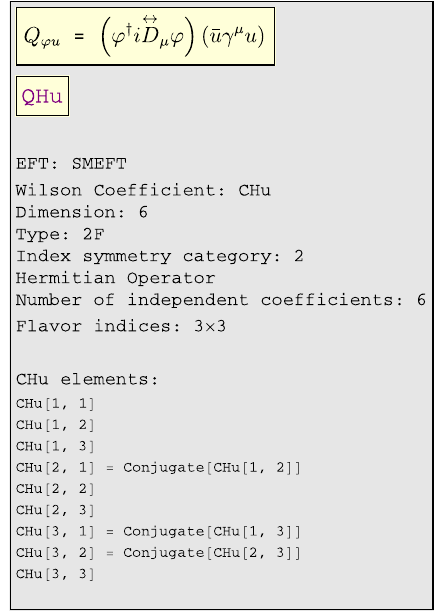
Fig. 3 Information about the SMEFT WC C ϕ u obtained after evaluating ObjectInfo[CHu] , or by using the interfaces SMEFTOperatorsMenu or